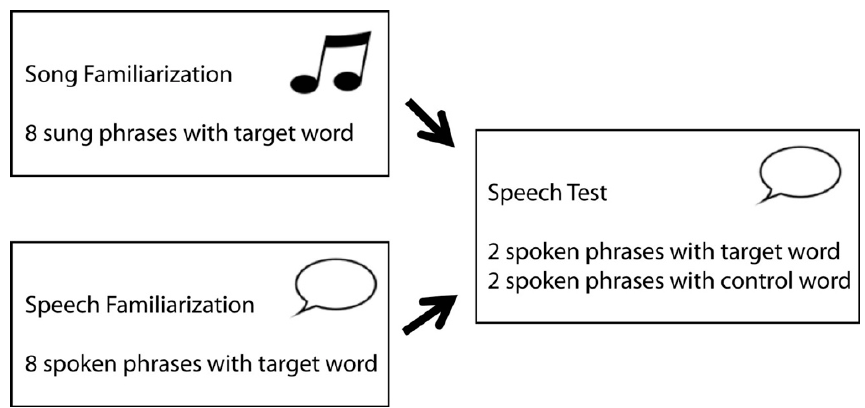
Figure 1. Setup of one experimental block of the study design.